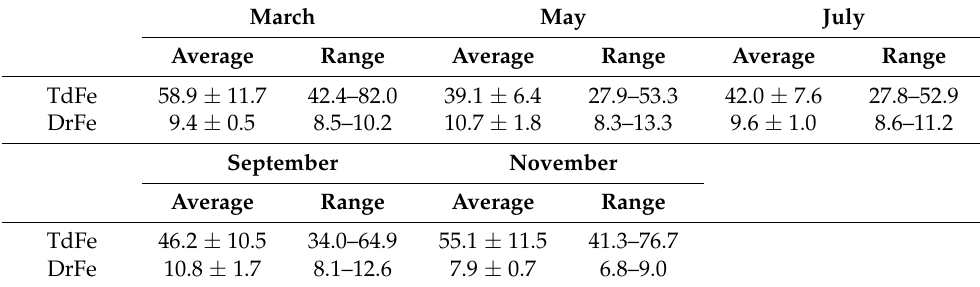
Table 2. The average and range of different iron speciation concentrations in Sishili Bay in 2018 (unit: nM).